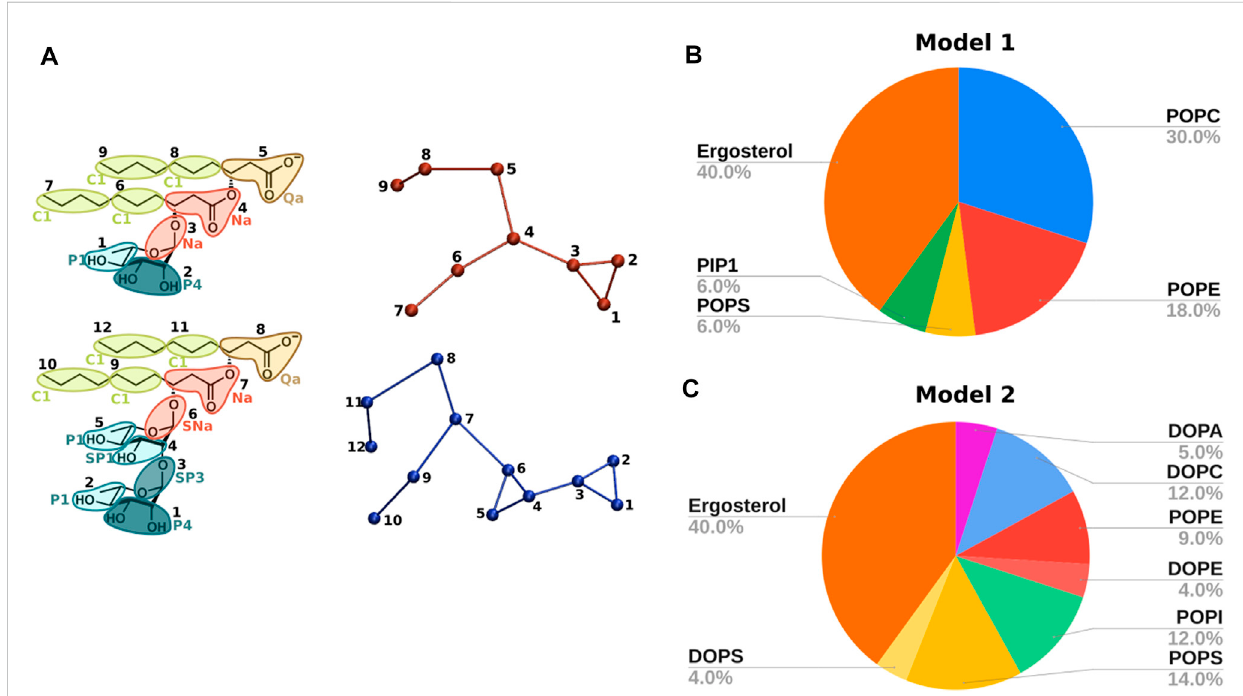
FIGURE 2 (A) CG topologies for mono-RL (top) and di-RL (bottom) with Martini bead assignments. Mapping colours refer to different bead types and the different tonalities to the polarity degree. Apolar, charged, intermediate and polar beads are respectively represented with green, brown, red and turquoise. (B) Phospholipid membrane model reproducing the composition of Fusarium oxysporum: POPC, POPE, POPS, PIP1 and ergosterol in molar ratios 30/18/6/6/40. (C) Phospholipid membrane model reproducing the composition of Saccharomyces cerevisiae : DOPA, DOPC, POPE,